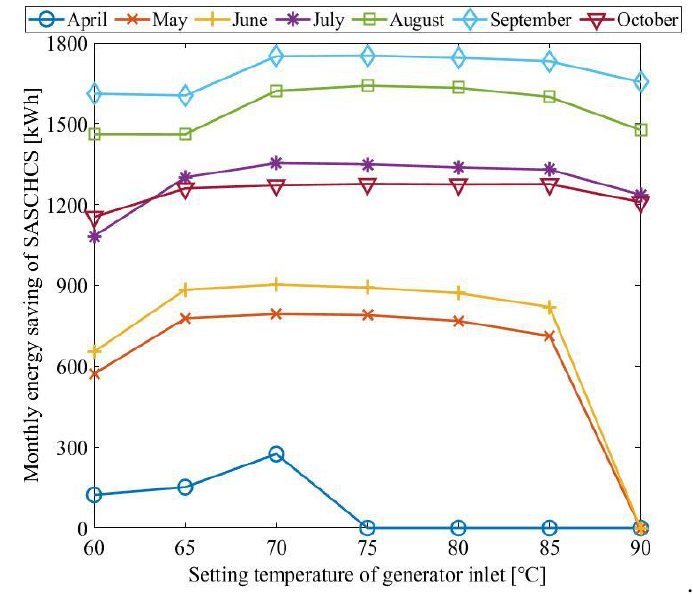
ff erent generator setting Figure 14. Energy saving for different generator setting temperatures. Figure 14. Energy saving for di